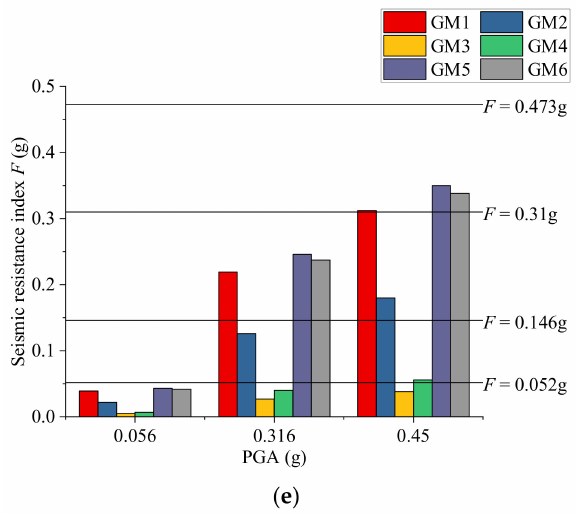
Figure 6. Structural damage states using the proposed design-strength-based method: ( a ) 3-story structure; ( b ) 5-story structure; ( c ) 8-story structure; ( d ) 12-story structure; ( e ) 18-story